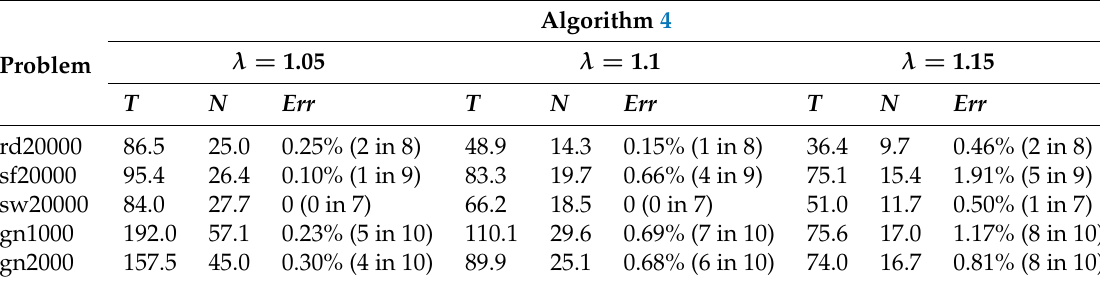
Table 5. Results for Algorithm 4 when λ